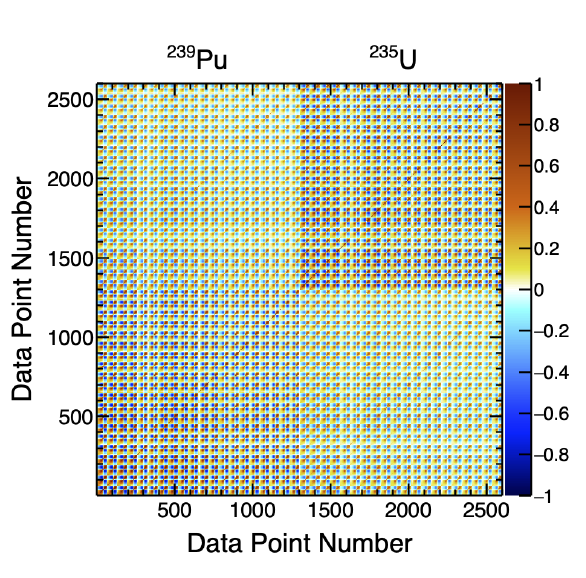
Figure 4: The cross-nuclide correlation matrix describing the correlations between Chi-Nu 239 Pu and 235 U PFNS re- sults for all incident and emitted neutron energies. See the text for a description of this